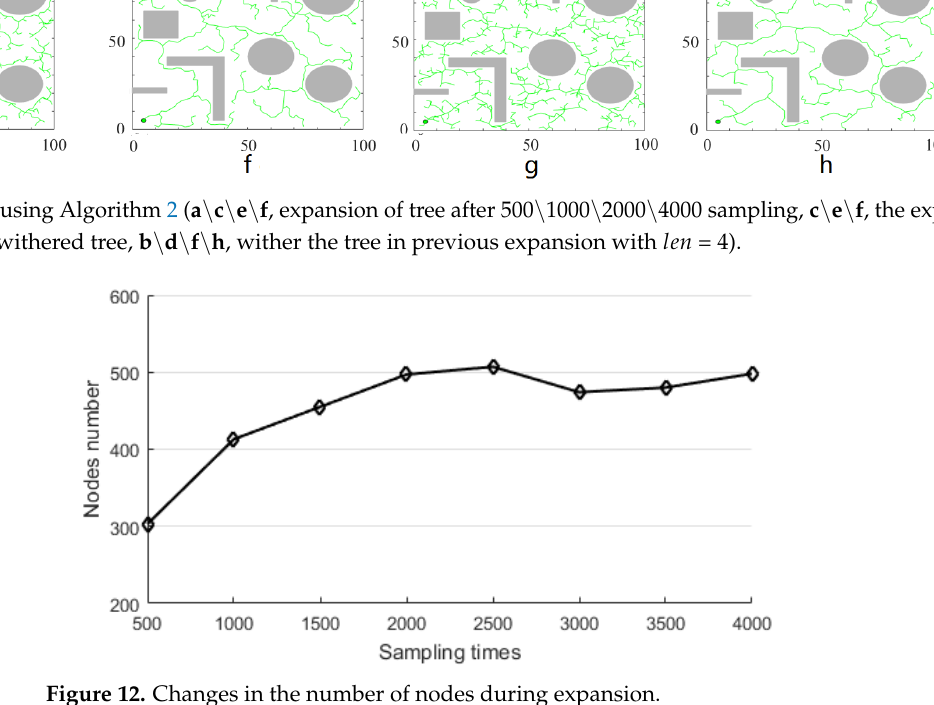
Figure 12. Changes in the number of nodes during